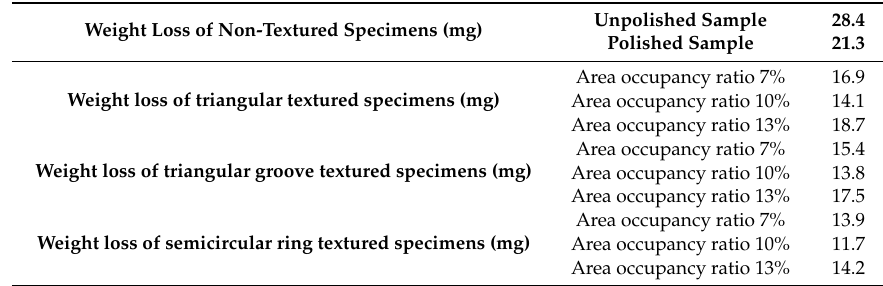
Table 8. Weight loss of non-textured specimens and textured specimens.